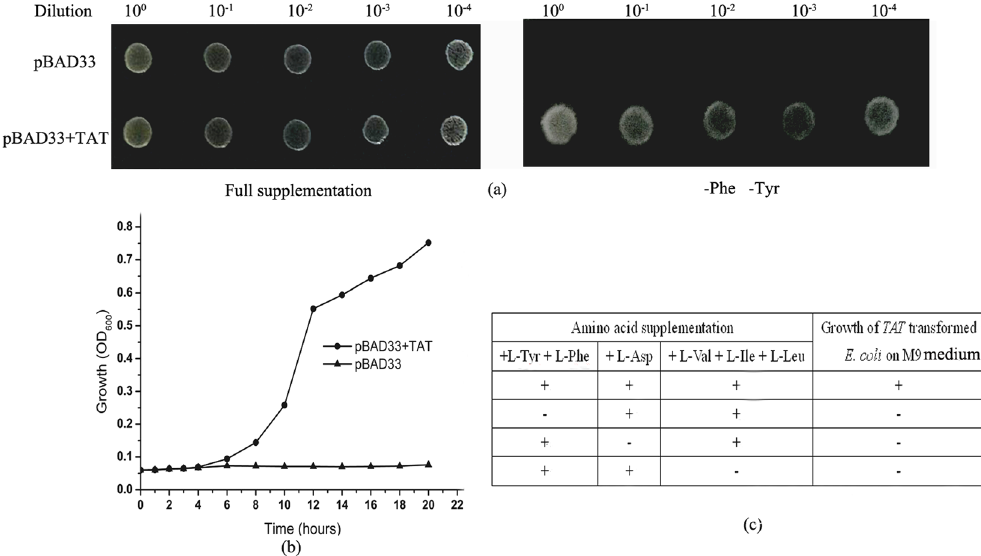
Figure 3. PvTAT complementation of the tyrosine-auxotrophic E . coli mutant DL39. PvTAT was cloned into the expression vector pBAD33 with an arabinose promoter. The recombinant pBAD33-TAT plasmid or empty plasmid was transformed into the E . coli triple mutant DL39. The bacteria were grown to an OD of 1.0 measured at 600 nm, the strains were serially diluted to 10 − 1 , 10 − 2 , 10 − 3 , and 10 − 4 using 0.85% (w/v) saline and 3 μ l was replica plated on medium with or without L-tyrosine and L-phenylalanine supplemented with 0.2% (w/v) arabinose. ( a ) All transformants could grow on solid M9 medium with full supplementation, but only the plasmids expressing PvTAT could grow on medium free of L-tyrosine and L-phenylalanine. ( b ) Within 20 hours, the growth curve of the DL39 strain transformed with either pBAD33 (triangle) or pBAD33 + TAT (circle) in liquid M9 medium lacking L-tyrosine and L-phenylalanine supplemented with 0.2% (w/v) arabinose. ( c ) The summary of the functional complementation assay of the plant enzyme ability to complement the E . coli triple mutant on M9